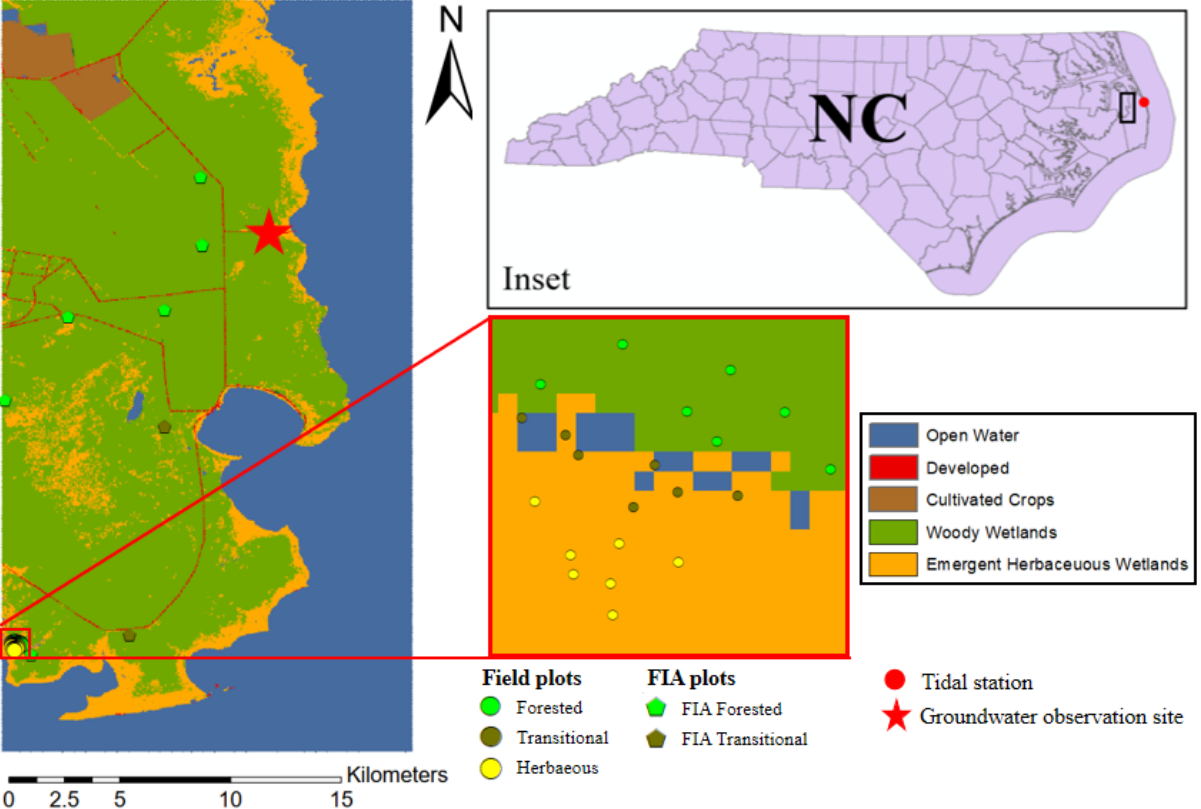
Figure 1. The study area (35.558–35.863 ◦ N, 75.693–75.859 ◦ W, excluding Open Water) with land cover types as determined by 2016 National Land Cover Database (NLCD). Inset: the location of the study area in North Carolina (NC). The black box in the inset indicates the study area. The red dot in the inset indicates the location of the NOAA tidal station (Oregon Inlet Marina, NC). The red star indicates the groundwater observation site (35.768 ◦ N, 75.750 ◦ W). The pentagon represents field plots in the Forest Inventory and Analysis (FIA) data set. The zoom-in figure in the red box shows the detailed spatial distribution of field plots obtained from Smart et al. [19], Poulter [48], and Taillie et al. [49].